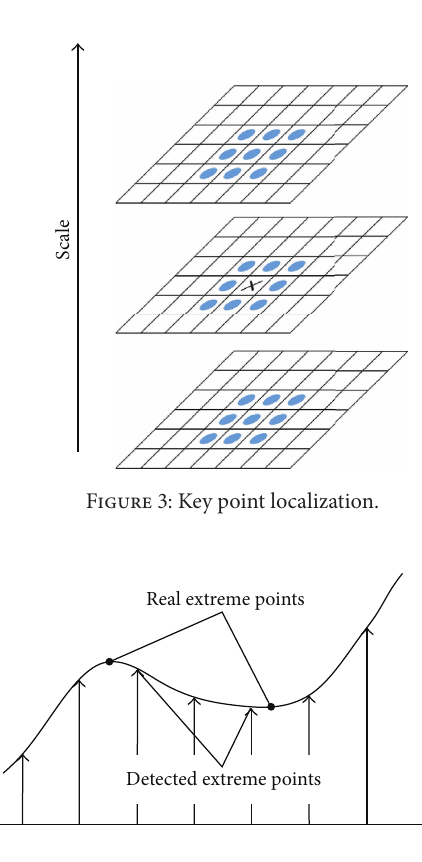
Figure 4: Difference between discrete space and continuous